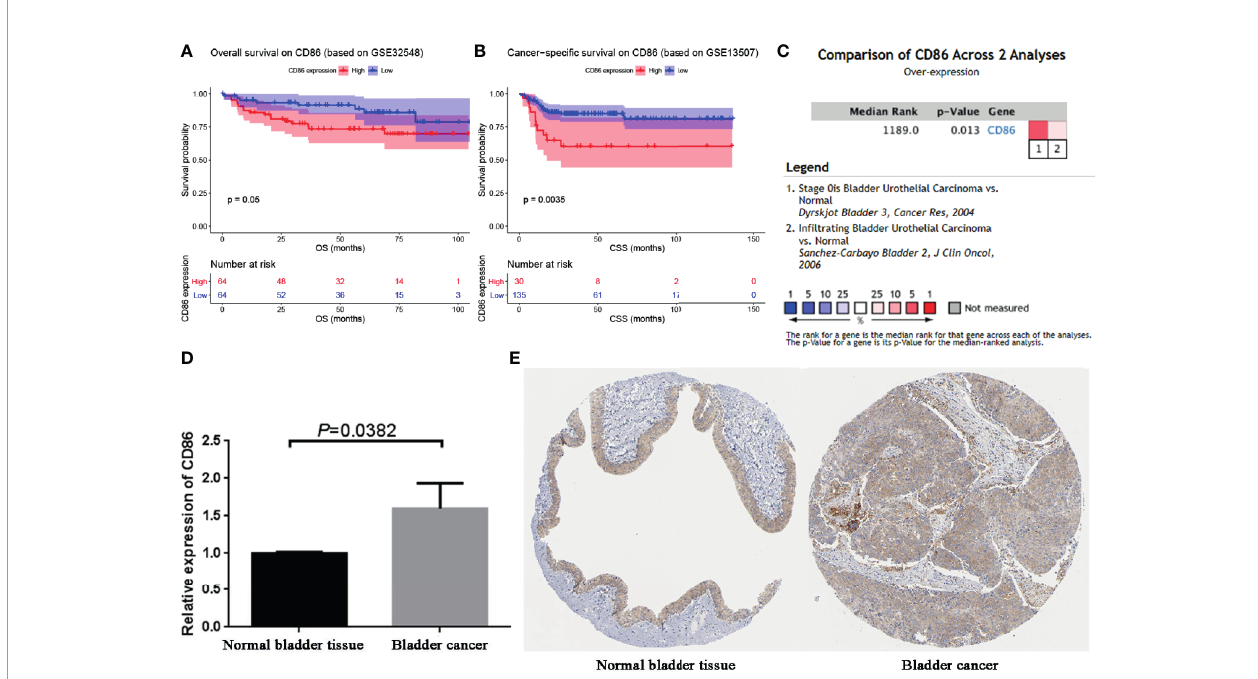
FIGURE 6 | Validation of CD86. (A) Survival analysis of the association between the CD86 expression level and overall survival time in BC (based on GSE32548). (B) Survival analysis of the association between the CD86 expression level and cancer-speci fi c survival time in BC (based on GSE32548). (C) Comparison of CD86 mRNA expression across 2 analyses of BC. (D) qRT-PCR analysis exhibited the expression of CD86 in bladder cancer tissues compared with the paired paracancerous tissues. (E) Validation of CD86 in translational level by The Human Protein Atlas database (IHC).